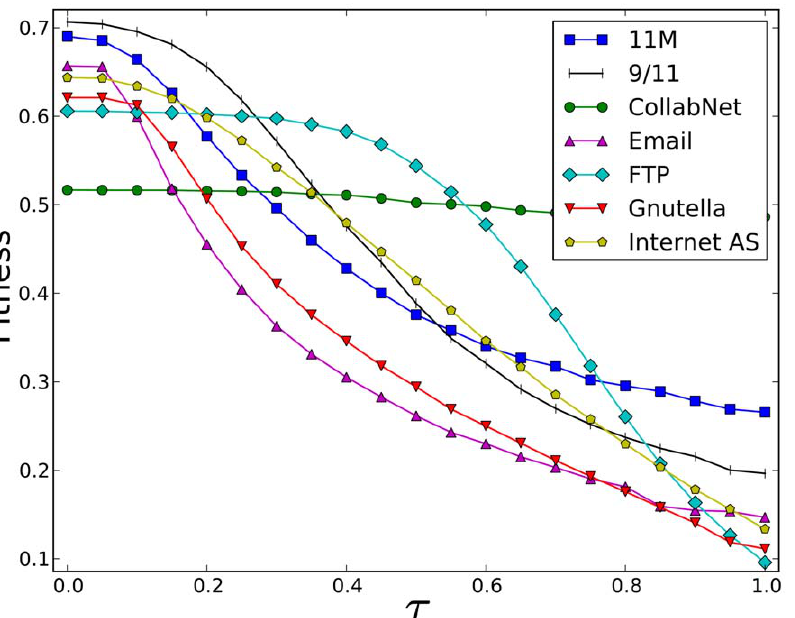
Figure 2. Fitnesses of various networks at r ~ 0 : 51 and various values of t . 11MisthenetworkresponsiblefortheMarch11,2004attacksinMadrid ( 70 nodes, 241 edges).9/11[28]isthenetworkresponsibleforthe9/11attacks( 62 nodes, 152 edges).CollabNet[29]isascientificco-authorshipnetworkinthearea ofnetworkscience( 1589 nodes, 2742 edges).E-Mail[37]isauniversity’se-mailcontactnetwork,showingitsorganizationalstructure( 1133 nodes, 5452 edges).FTP is the networkinFig.1( 174 nodes, 300 edges).Gnutella[38,39] is asnapshotofthepeer-to-peernetwork( 6301 nodes, 20777 edges).InternetAS[40]is asnapshot of the Internet at the autonomous system level ( 26475 nodes, 53381 edges). Except for t w 0 : 6 dark networks (11M, 9/11 and FTP) attain the highest fitness.